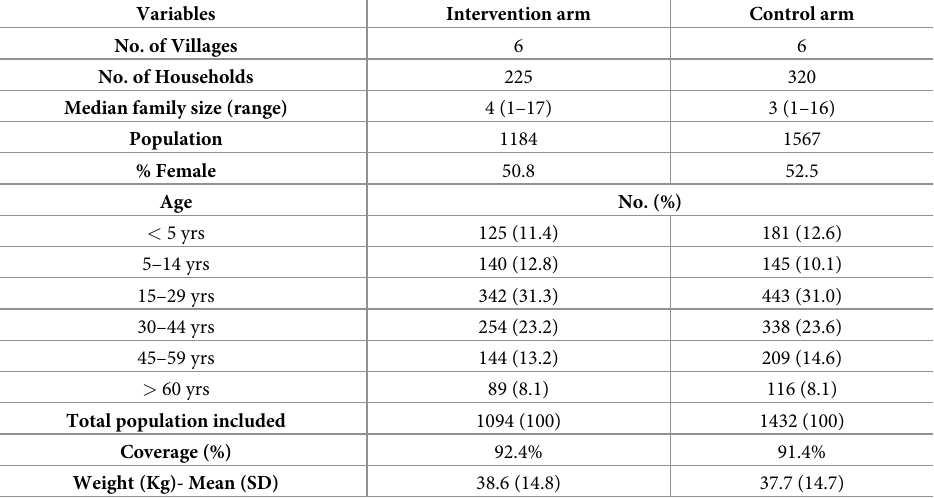
Table 1. Baseline characteristics of the